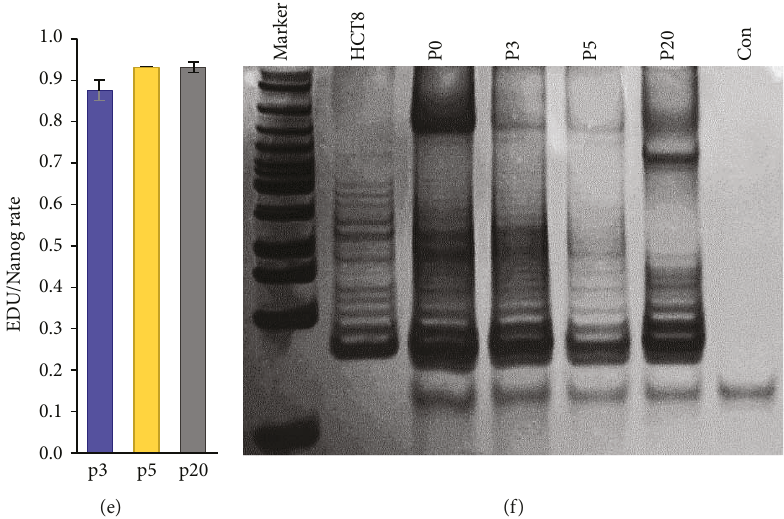
Figure 4: Characteristics of cESCs in a long culture period. This culture system can stably maintain the stem-like character of cESCs in vitro for a long term. (a) Epitope characteristic of cultured cESCs in passages 3, 5, and 20. The pluripotency surface marker SSEA-1 (green) was stained. Meanwhile, DAPI (blue) was used to stain the nucleus. (b) SSEA-1 expression was maintained at a relatively stable level. The ImageXpress Micro XLS Wide fi eld High-Content Analysis System was used. The bars indicated the positive SSEA-1 mean cell average intensity of cultured cESCs in passages 3, 5, and 20. (c) Lin28a , Nanog , and PouV gene mRNA relative expression level of cultured cESCs in passages 3, 6, 9, and 20. ∗ Compared to the expression level of cultured cESCs in passage 3, P < 0 05 . (d) Nanog expression characteristic of cultured cESCs in passages 3, 5, and 20. The fi gure indicated the merged picture of DAPI, Nanog, and EDU staining. (e) The positive proliferation rate of cultured cESCs was maintained at a relatively high level over passages 3, 5, and 20. The bars indicated the ratio of